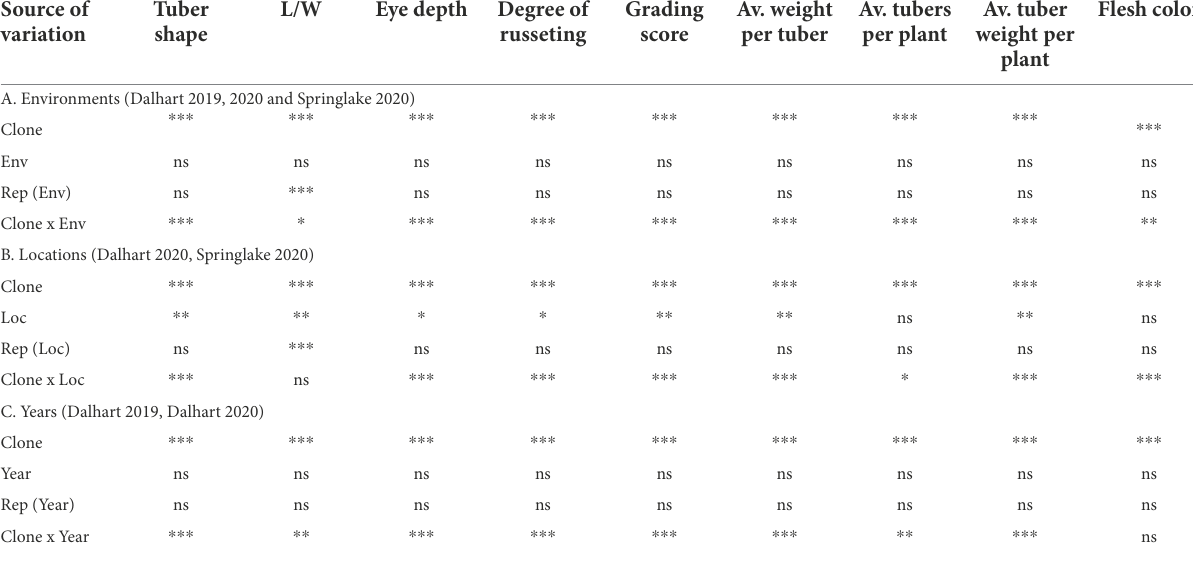
TABLE 3 Analysis of variance assessing the effect of (A) environments (Env), (B) locations (Loc), and (C) years on the tuber morphology traits in 214 tetraploid advanced potato clones evaluated in Texas. Source of Tuber L/W variation shape